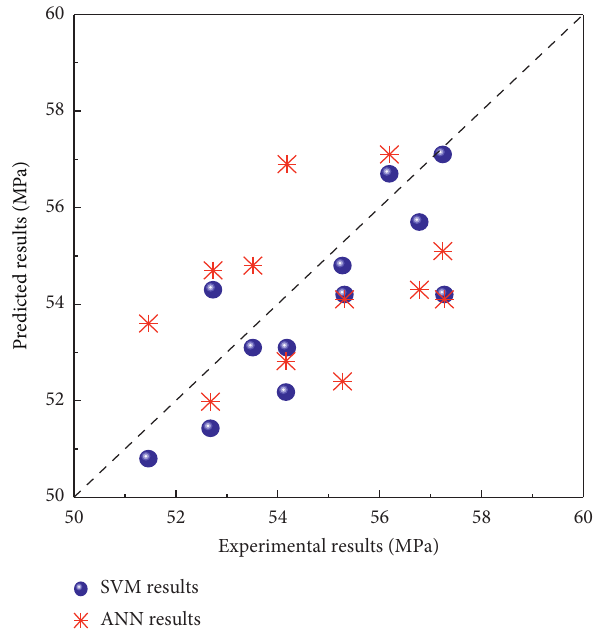
Figure 10: Experimental versus predicted CS.